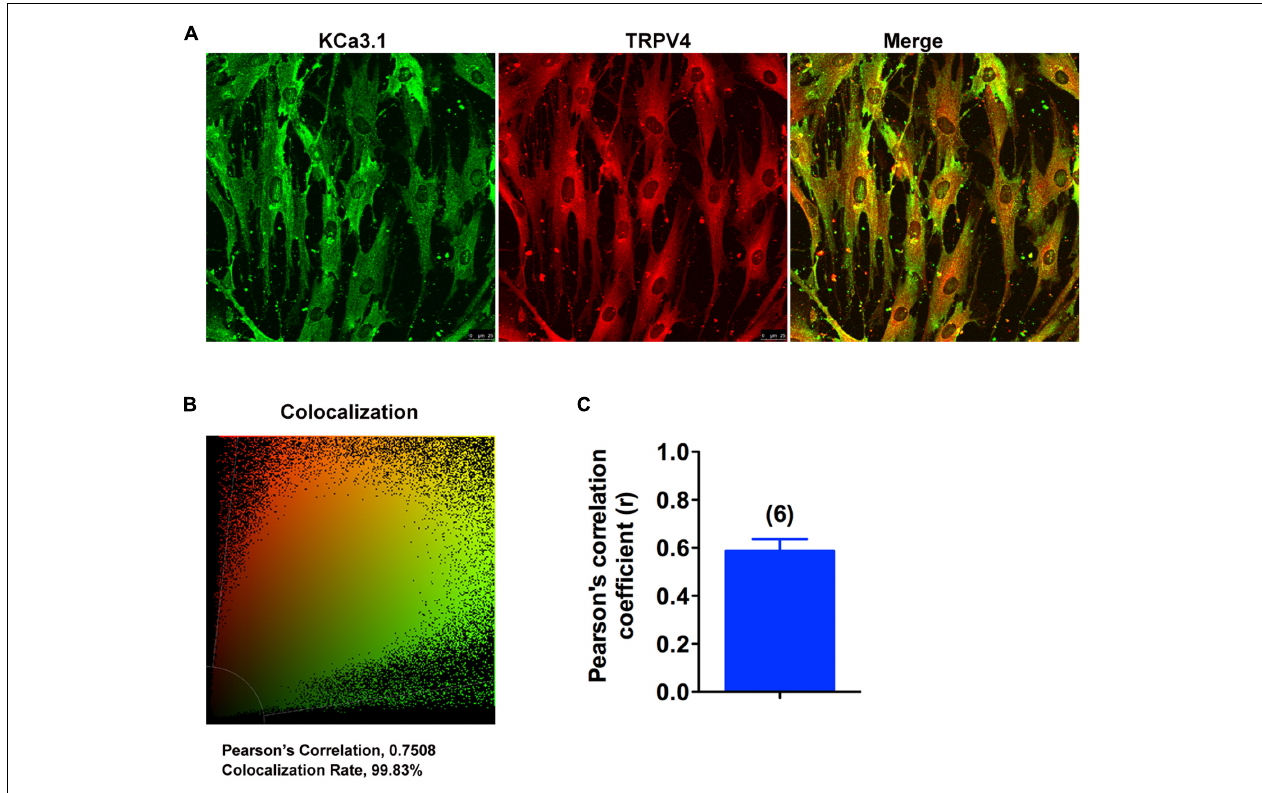
FIGURE 7 | KCa3.1 and TRPV4 appear colocalized in asthmatic HBSM cells. (A,B) Double immunofluorescence images of KCa3.1 (green) and TRPV4 (red) in HBSM cells. Note the strong colocalization indicated by merge yellow fluorescence, quantification of the colocalization observed in experiments as shown in (C) . (C) The histograms represent the ratio of the mean Pearson correlation coefficient calculated from the colabeling in a number of samples, as indicated above the bar. Scale bar: 25 µ